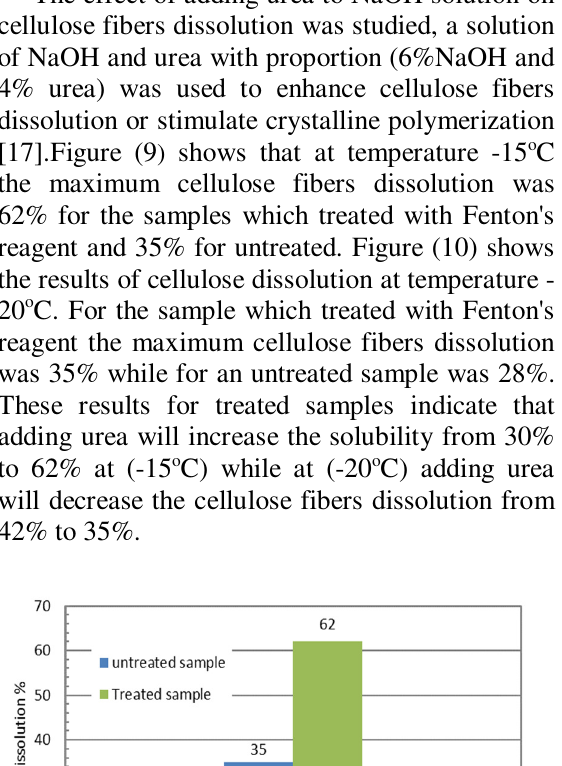
Fig. 9. Effect of urea addition on cellulose dissolution at temperature - 15 ±2 o C.